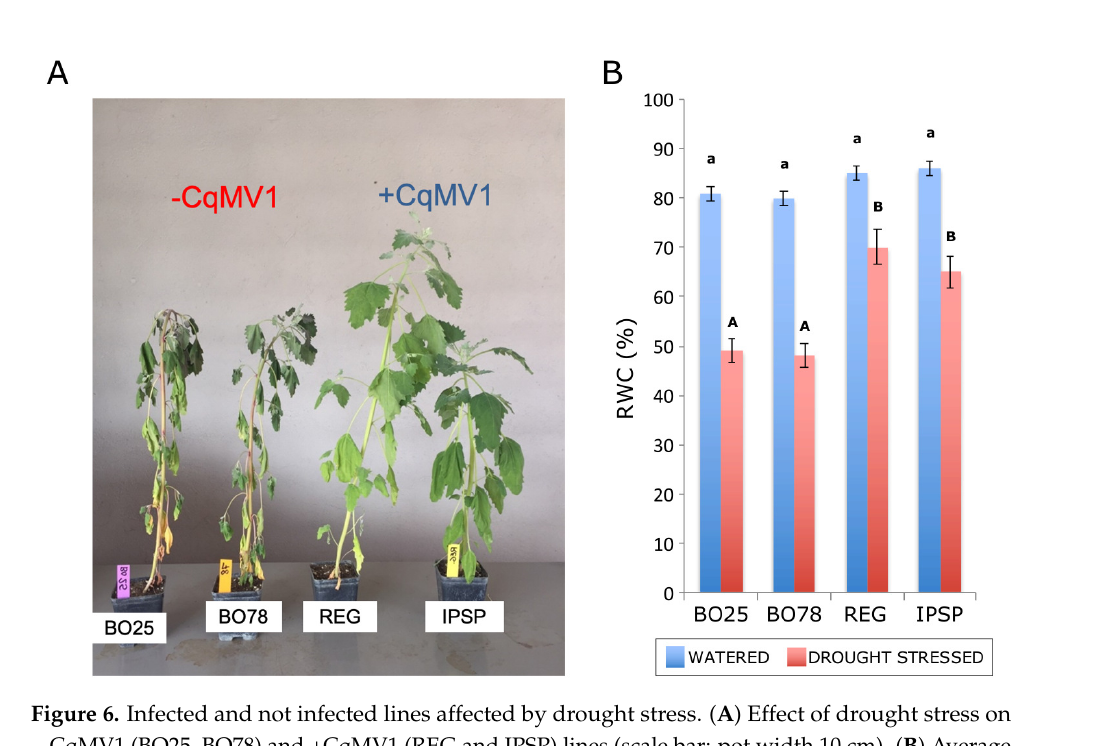
Figure 6. Infected and not infected lines affected by drought stress. ( A ) Effect of drought stress on − CqMV1 (BO25, BO78) and +CqMV1 (REG and IPSP) lines (scale bar: pot width 10 cm). ( B ) Average values of relative water content (RWC) of leaves under watered (blue bars) and drought (red bars) conditions. Different letters indicate statistically significant difference ( p ≤ 0.05) within the watered (lowercase letters) and drought stress (capital letters) samples of 5 independent biological replicates ( n = 5); Anova and Tukey’s test were